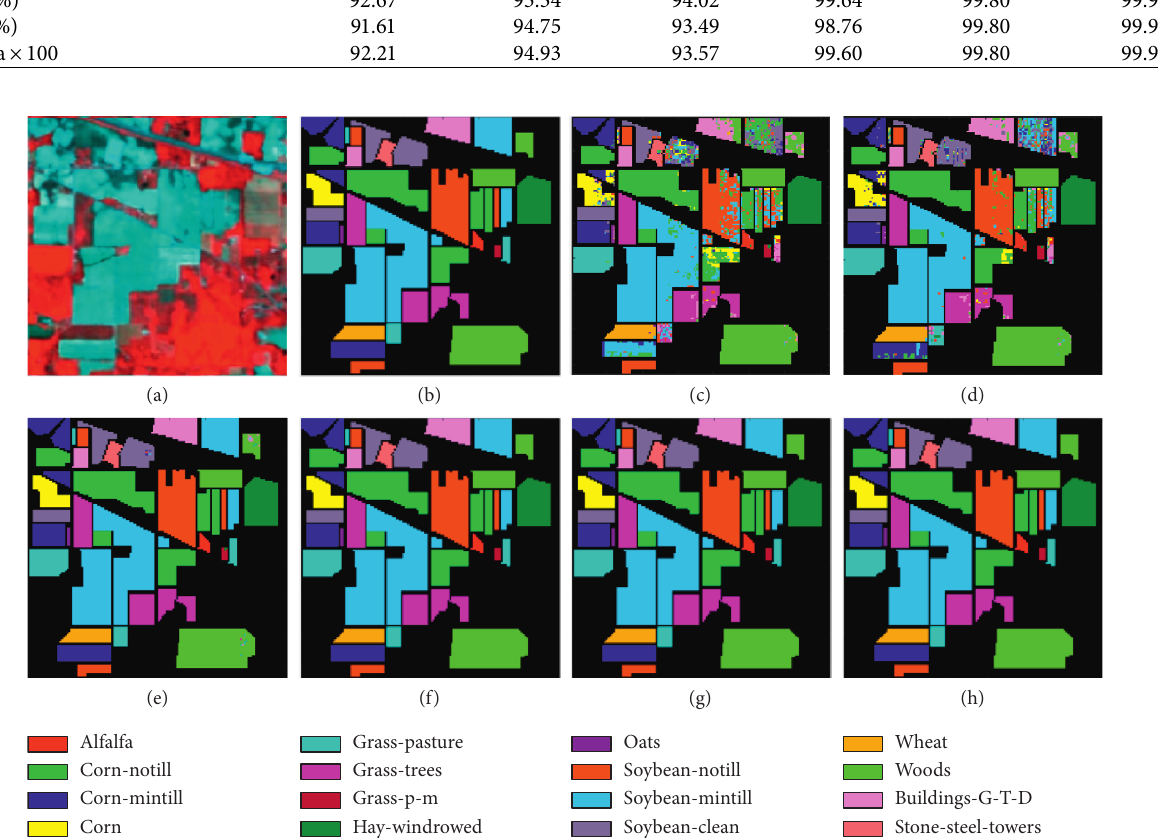
Figure 12: Classification results of the models in comparison with the UP dataset. (a) False color image, (b) ground truth, and (c)-(h) predicted classification maps for SVM-RBF, 2D CNN, 3D CNN, SSRN, HybridSN, and proposed